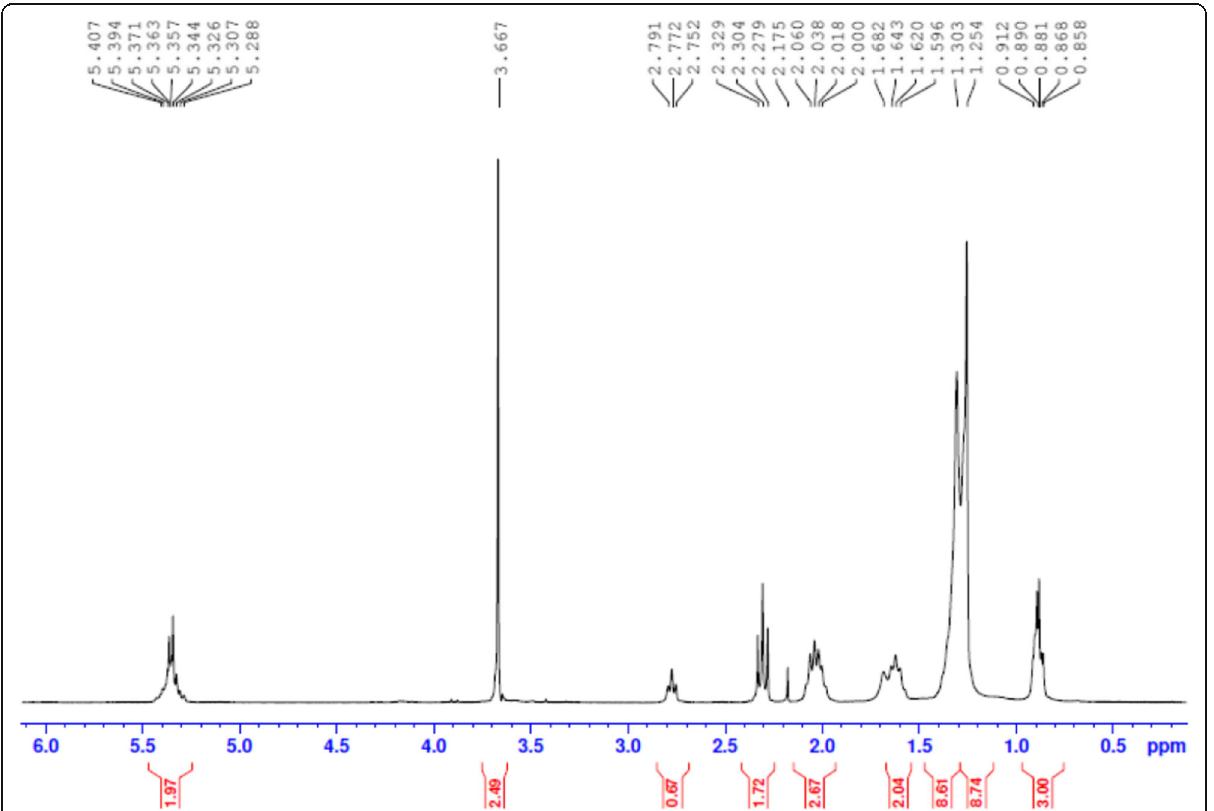
Fig. 8 1 H-NMR spectrum of the synthesized